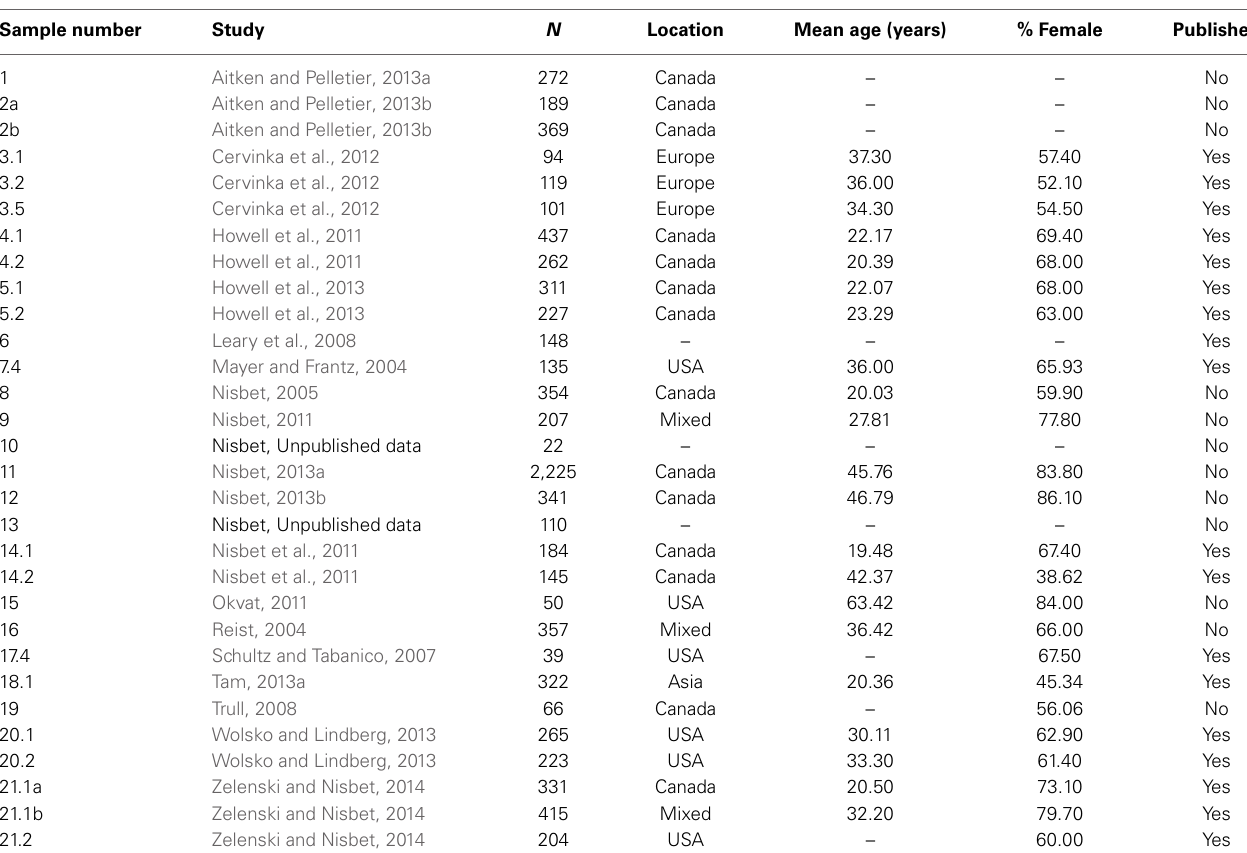
Table 3 | Descriptive information for included